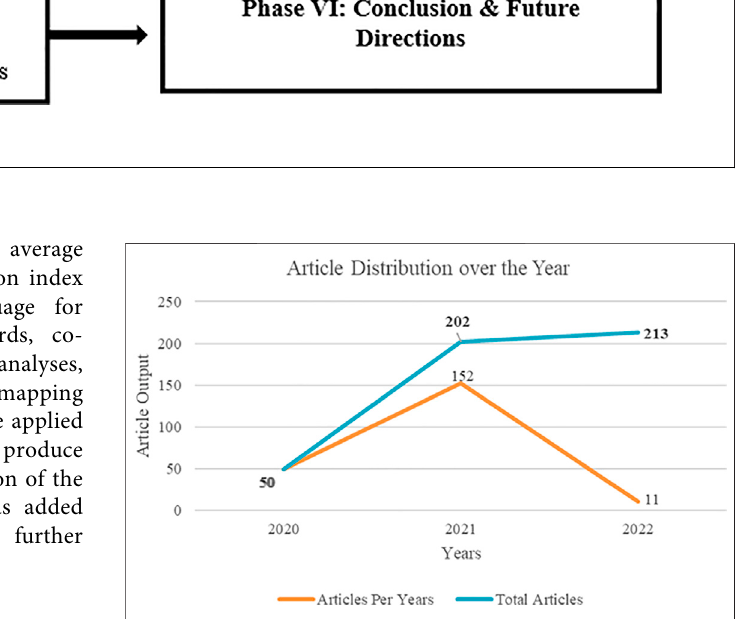
FIGURE 2 | Article distribution over the